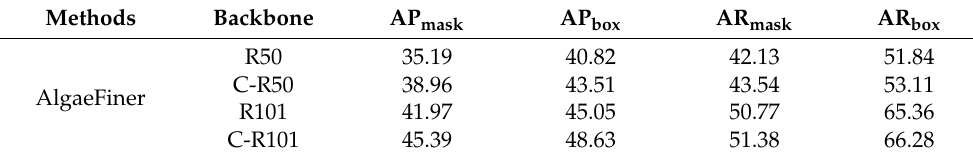
Table 8. The comparison of AP mask ,AP box , AR mask , and AR box under different backbones.